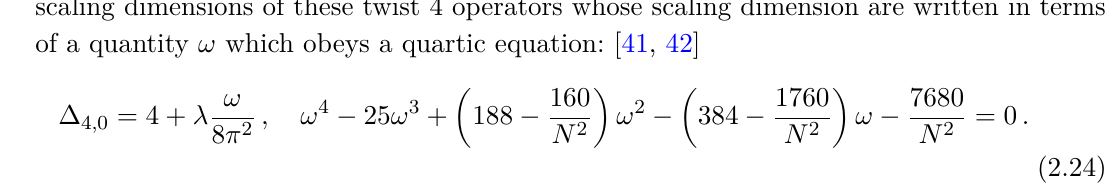
Figure 2 . The localization inputs for SU (2) for θ = 0 as a function of g 2 of τ along the arc from e πi/ 3 to e 2 πi/ 3 ( below ). We include terms with up to 10 instantons in (2.19), which as shown in appendix A is more than sufficient for convergence inside the fundamental domain. Note that the slope of these inputs goes to zero at the Z 2 self-dual point τ = i and at the Z 3 self-dual point τ = e πi/ 3